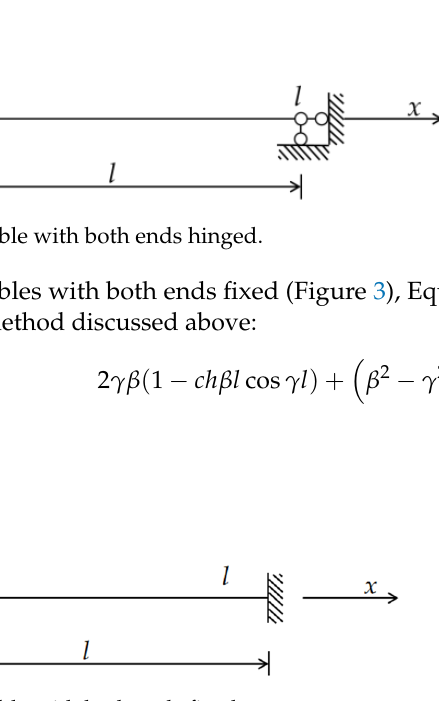
Figure 2. Cable with both ends hinged.